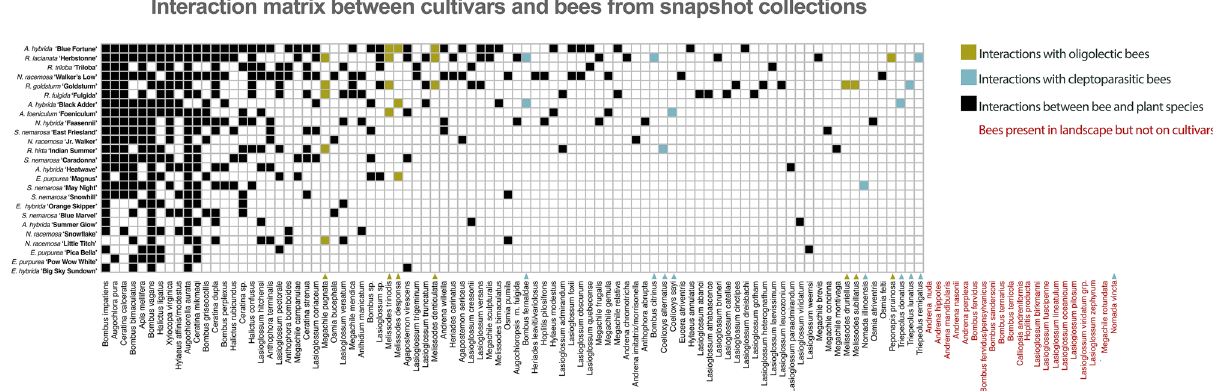
Figure 5. Cultivars are on the vertical axis and bee species (snapshot and background collections) are on the horizontal axis. The cultivars in this study interact with a diversity of species, including uncommon dietary specialists and cleptoparasitic species. Certain cultivars have the potential to contribute to community